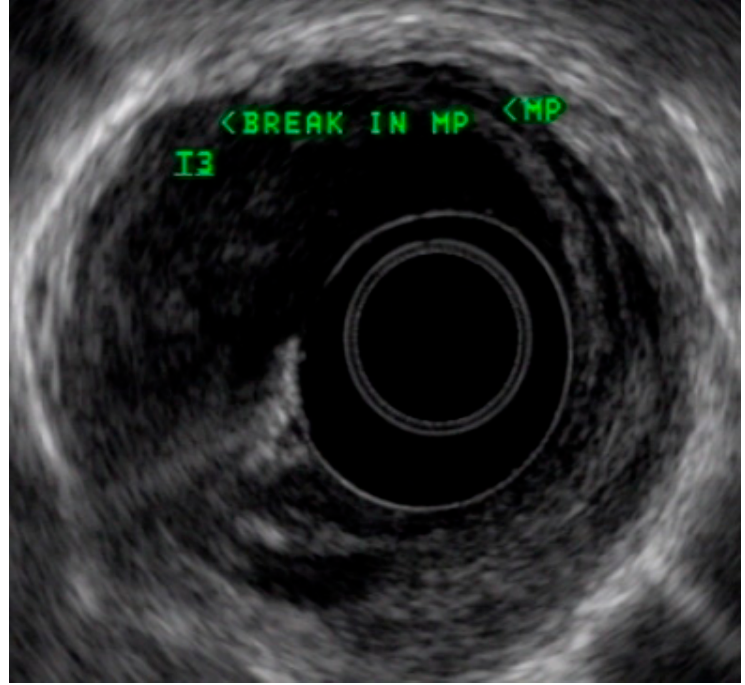
Figure 4. Esophageal cancer endoscopic ultrasound (EUS) image T3.